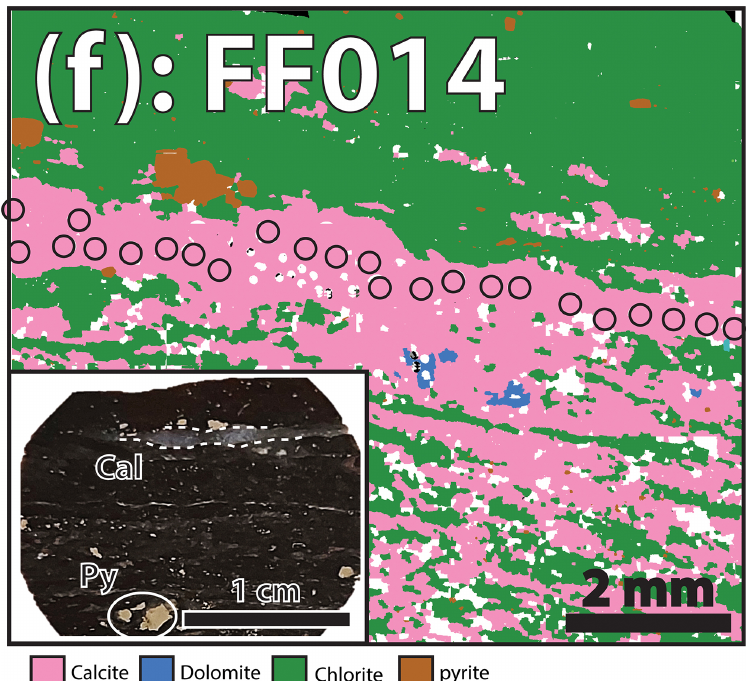
Figure C6. Large image of sample FF014 from Flin Flon, Manitoba and Saskatchewan, Canada. Large images shows SEM mineral map with black circles showing laser spot locations. Inset shows hand sample photo. Py: pyrite; Cal: calcite.